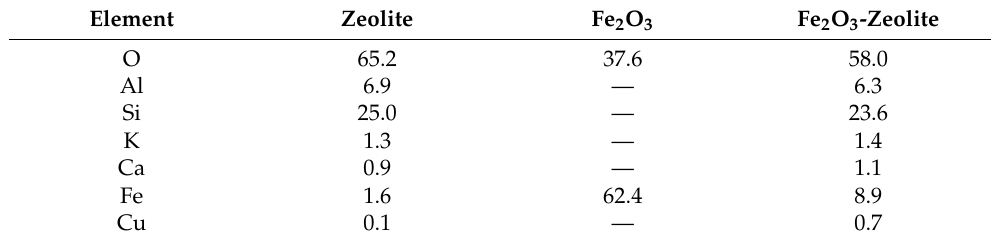
Table 1. The Atomic ratio of zeolite, Fe 2 O 3 , and Fe 2 O 3 -zeolite photocatalysts.